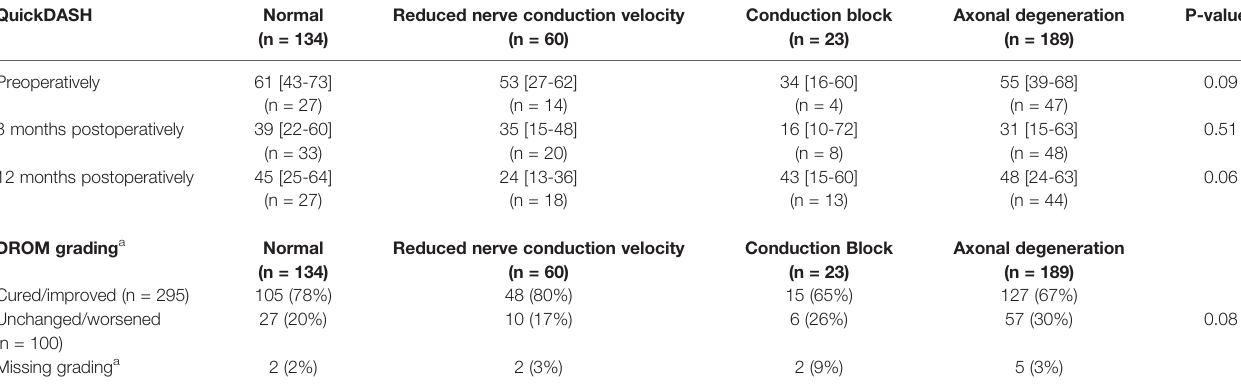
TABLE 3 | Relation between electrophysiologic grading and postoperative outcome using QuickDASH or DROM grading score in 406 and 395, respectively, surgically treated cases with ulnar nerve entrapment, irrespective of surgical method.